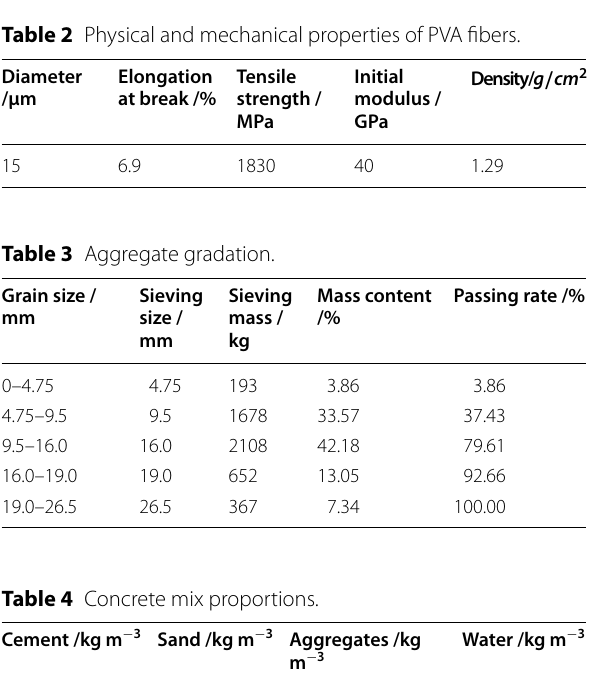
LOI is the loss on ignition, namely the percentage of weight lost after ignition between 1000 and 1100 °C